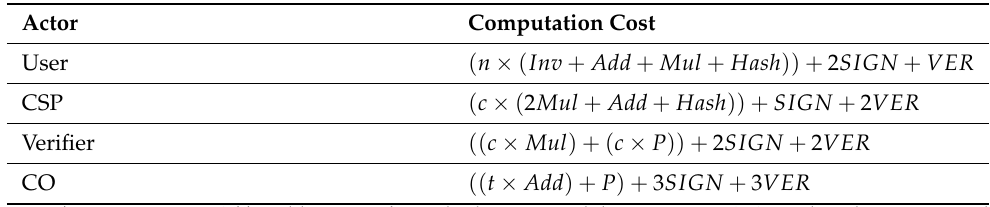
Table 2. Computation costs of each actor.